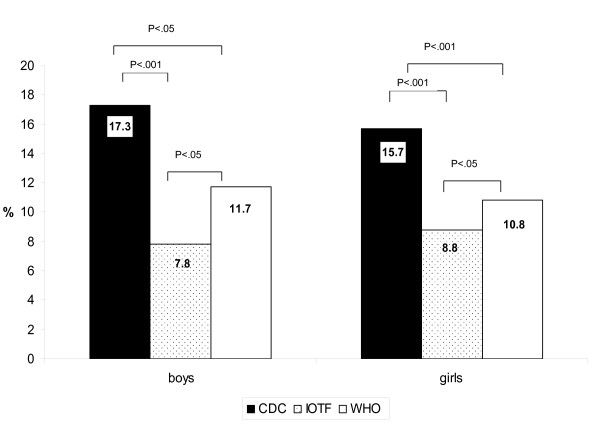
Prevalence of obesity in boys and girls using CDC, IOTF and WHO growth references. CDC: The Centres for Disease Control and Prevention, IOTF: The International Obesity Task Force, WHO: The World Health Organization. p < . 05 significant, ns: not significant